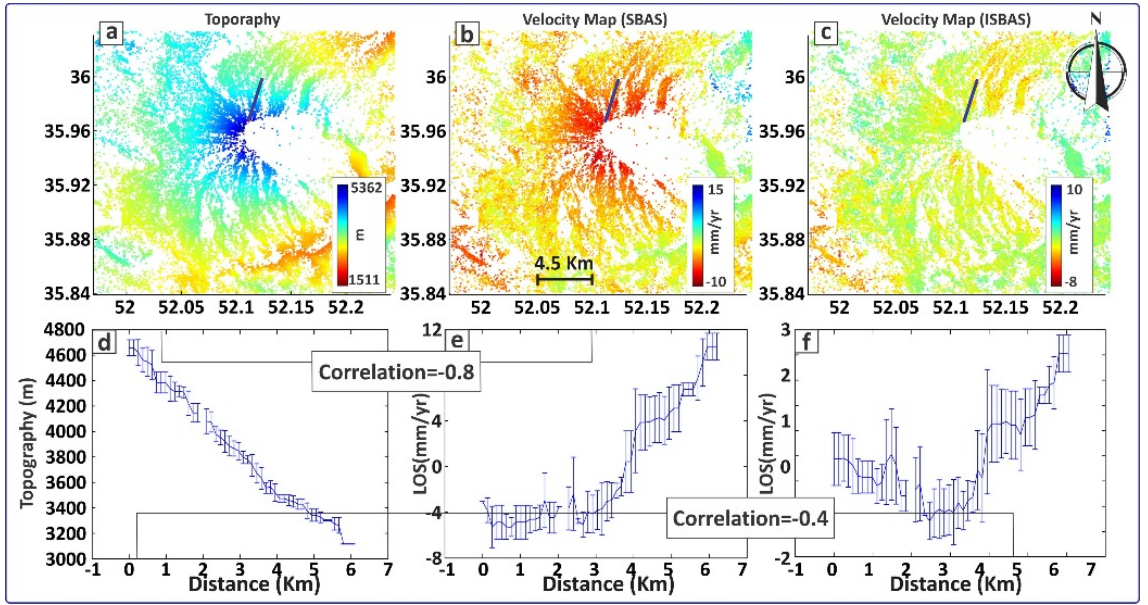
Figure 7. ( a ) Topographic map. ( b ), ( c ) are ground deformation velocity maps from Envisat descending data calculated by standard SBAS and ISBAS methods, respectively. ( d ) Topographic profile extracted from (a). ( e ) and ( f ) are displacement profiles extracted from (b) and (c), respectively. Correlation coefficients were determined at the 95% confidence level.